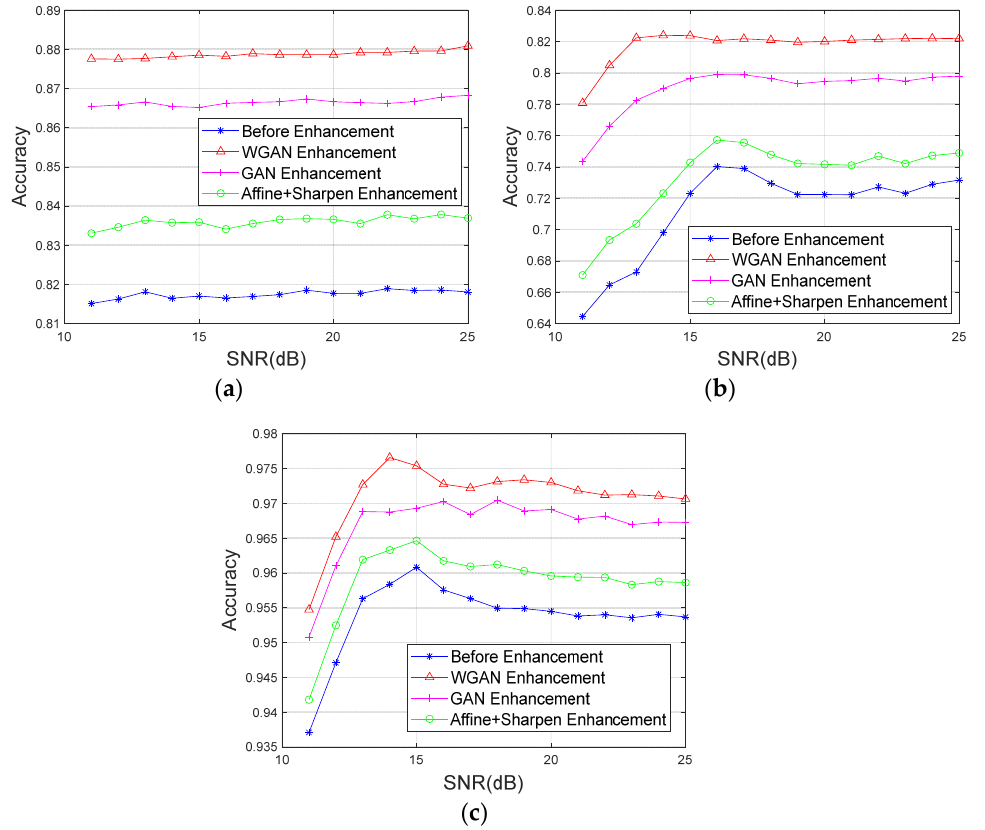
Figure 18. Comparison of the test accuracy before and after data enhancement under different SNR values. ( a ) Simulation data; ( b ) semi ‐ measured data; ( c ) measured data.